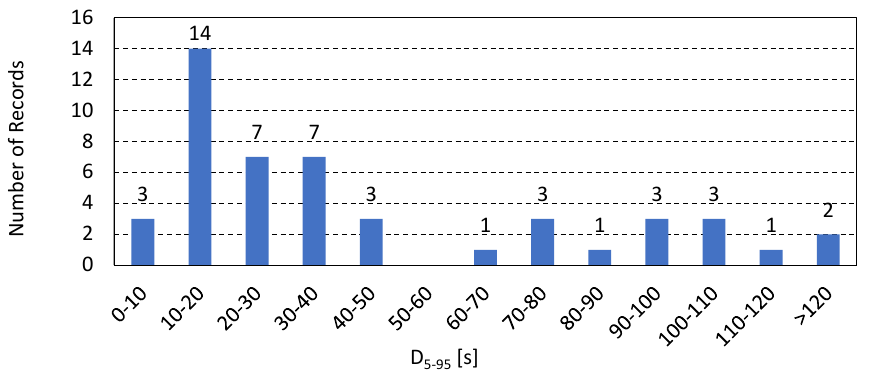
Figure 6. Distribution of D 5-95 ground motion duration.